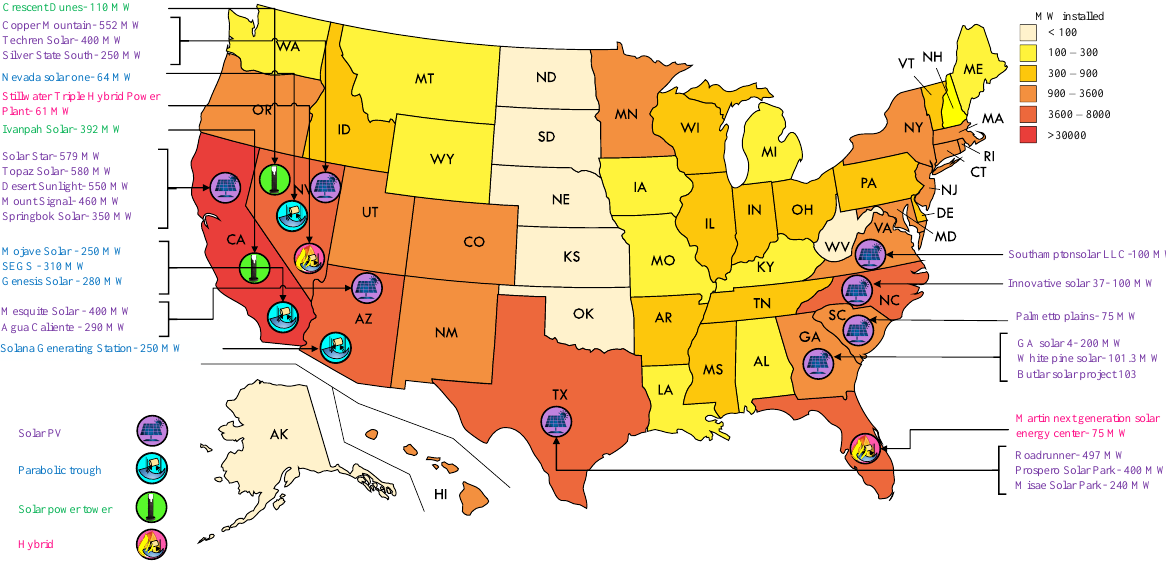
Figure 12. The state-wise heat map of the US showing the installed solar capacity and major solar plants classified by the type of solar technology